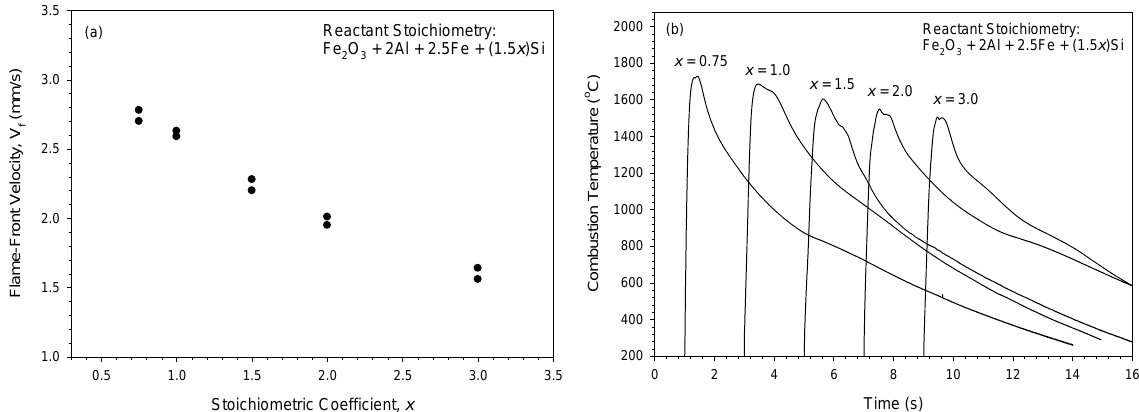
Figure 3. Effects of stoichiometric coefficient x on ( a ) flame-front propagation velocity and ( b ) combustion temperature.